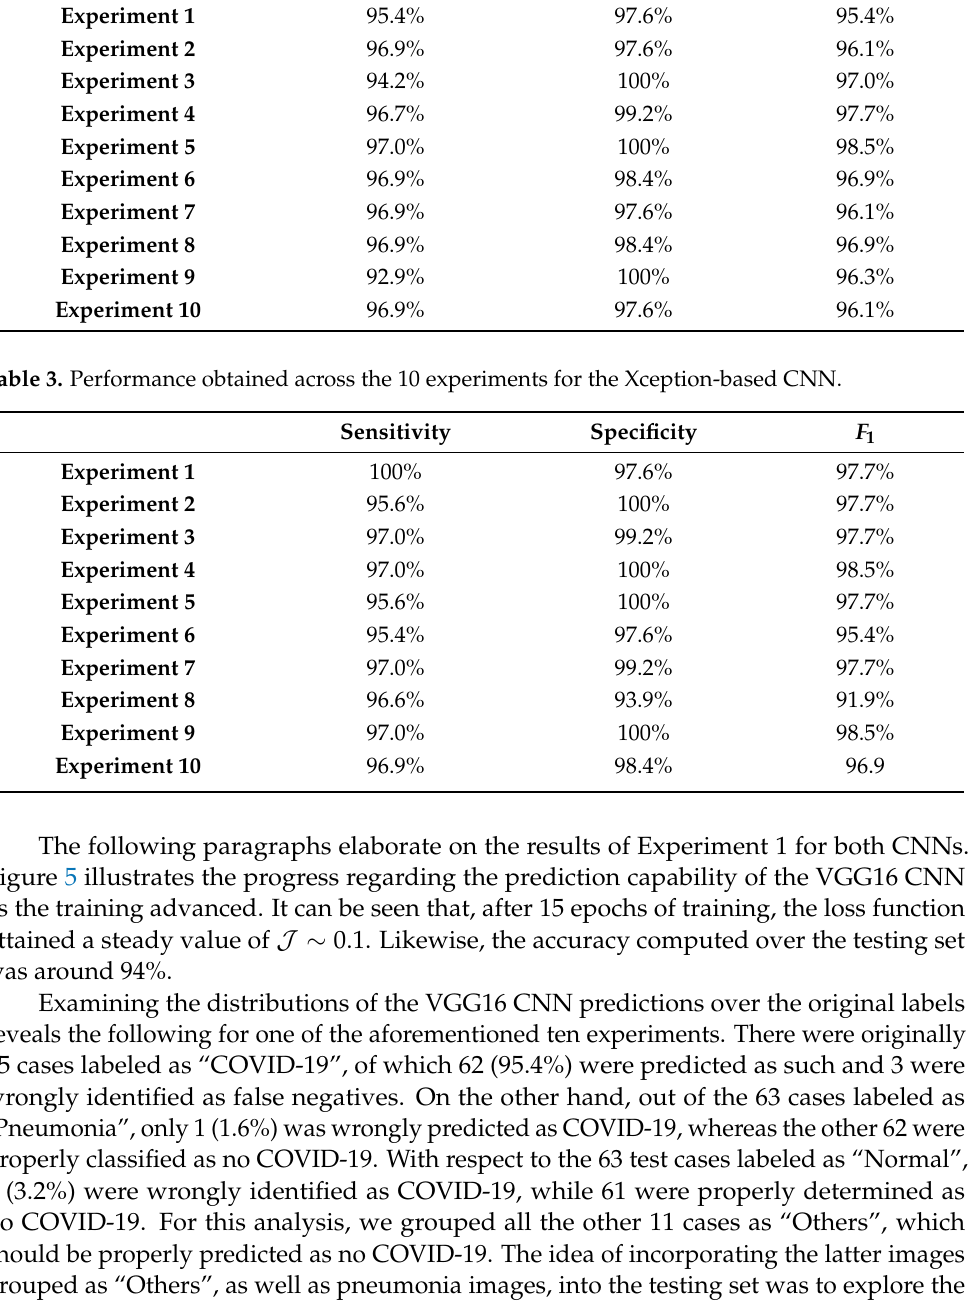
Table 2. Performance obtained across the 10 experiments for the VGG16-based CNN. Sensitivity Specificity